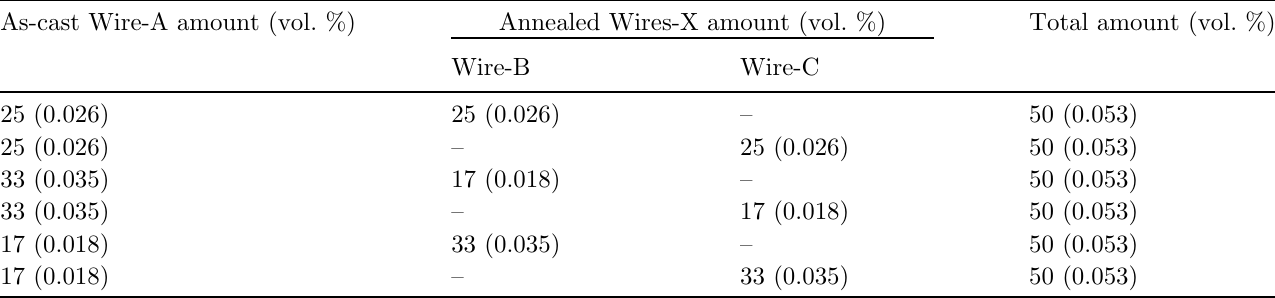
Table 1. Filler proportion in the composites combining as-cast A and annealed short-cut wires X (B: 30 mA or C: 40 mA) distributed in separated regions. As-cast Wire-A amount (vol. %)